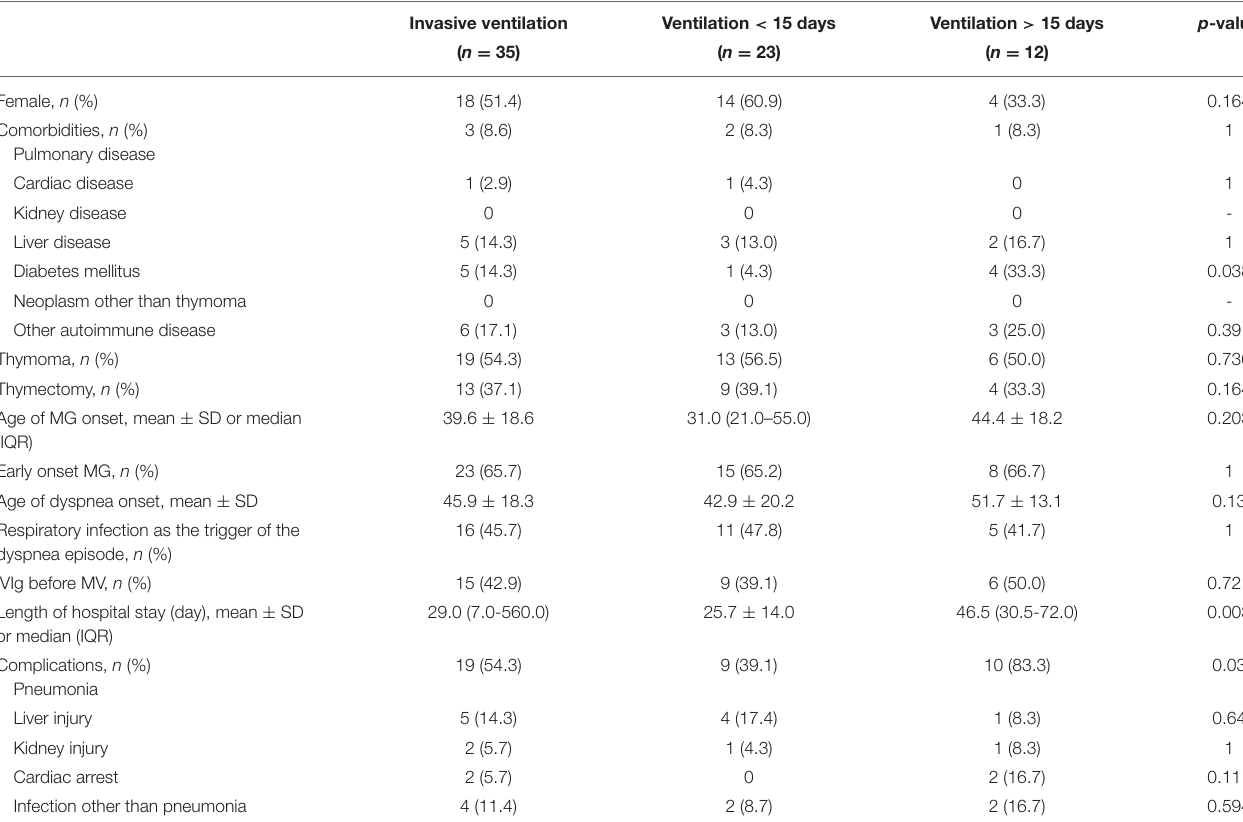
TABLE 4 | The characteristics of patients requiring invasive ventilation longer than 15 days. Invasive